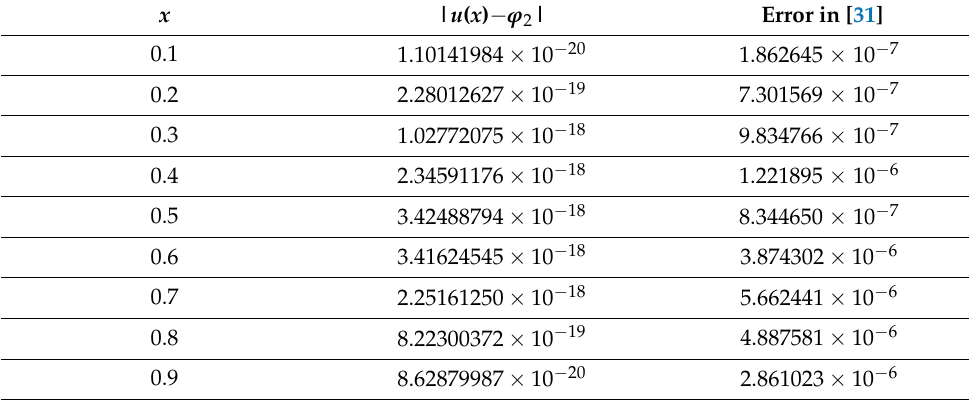
Table 5. The absolute error between the exact solution and ( ϕ 2 ) in Example